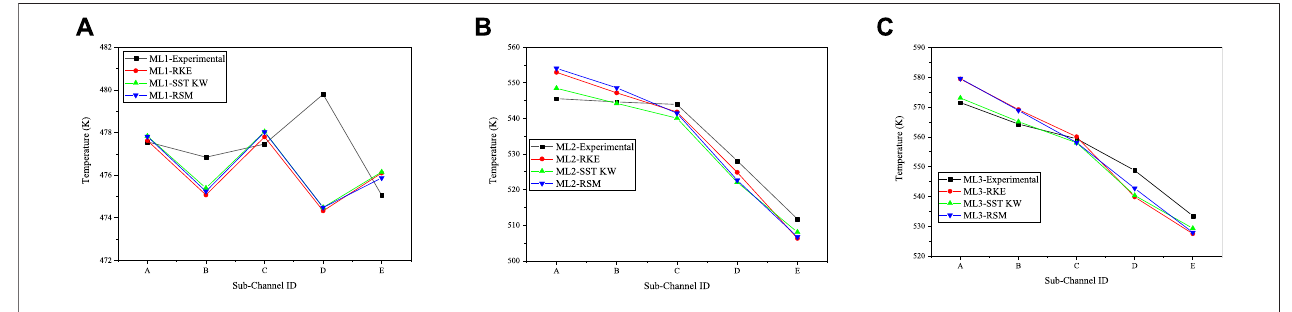
FIGURE 13 | Comparison of the temperature at the center of sub-channels. (A) ML1. (B) ML2. (C) ML3.